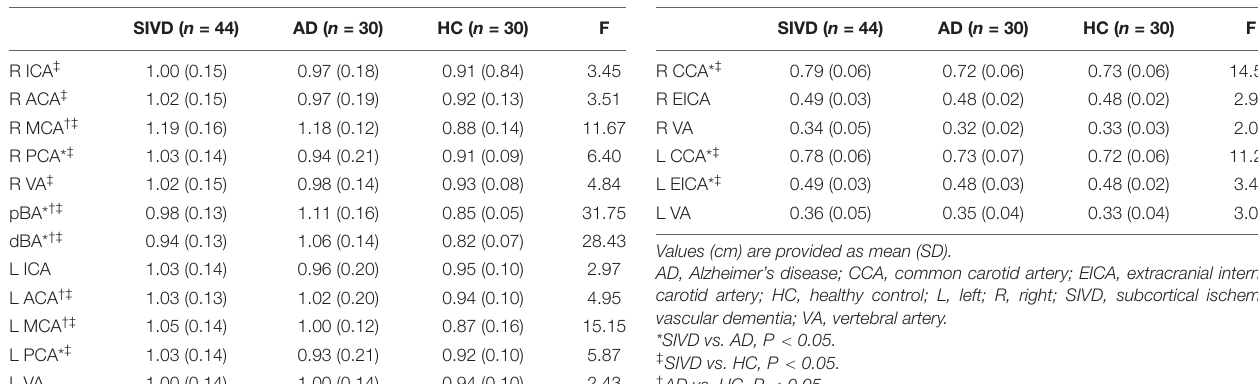
TABLE 3 | Pulsatility indices (PIs) of insonated arteries by the group. TABLE 4 | Lumen diameter of carotid arteries by the